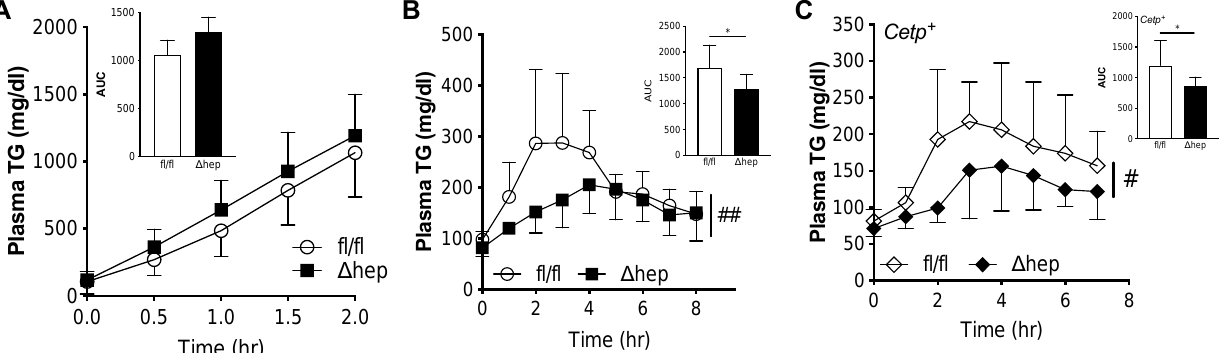
Figure 5. Effect of hepatic deletion of SHP on TG kinetics. ( A ) Plasma TG over time/TG production rate (inset panel) were measured following i.v. injection of Tyloxapol (500 mg/kg) in 3 h fasted male SHP fl/fl and SHP ∆ hep littermates (2-way Repeated Measures ANOVA, n = 7–10/group). ( B ) Mice were fed 20% fructose for 10 weeks. Overnight fasted mice of male SHP fl/fl and SHP ∆ hep littermates were orally gavaged with olive oil (200 µ L/mouse), postprandial TG excursion over 8 h and AUC were measured. ( C ) SHP ∆ hep mice were crossed with mice expressing the transgene of Cholesteryl Ester Transfer Protein (CETP) to generate CETP + /SHP fl/fl and CETP + /SHP ∆ hep . Overnight fasted male mice were orally gavaged with olive oil (200 μ L/mouse) and postprandial TG excursion were measured. Data shown are mean ± SD ( n = 6~8/group), # p < 0.05 and ## p < 0.01 for genotype effect (2-way Repeated Measures ANOVA), * p < 0.05 ( t -test).